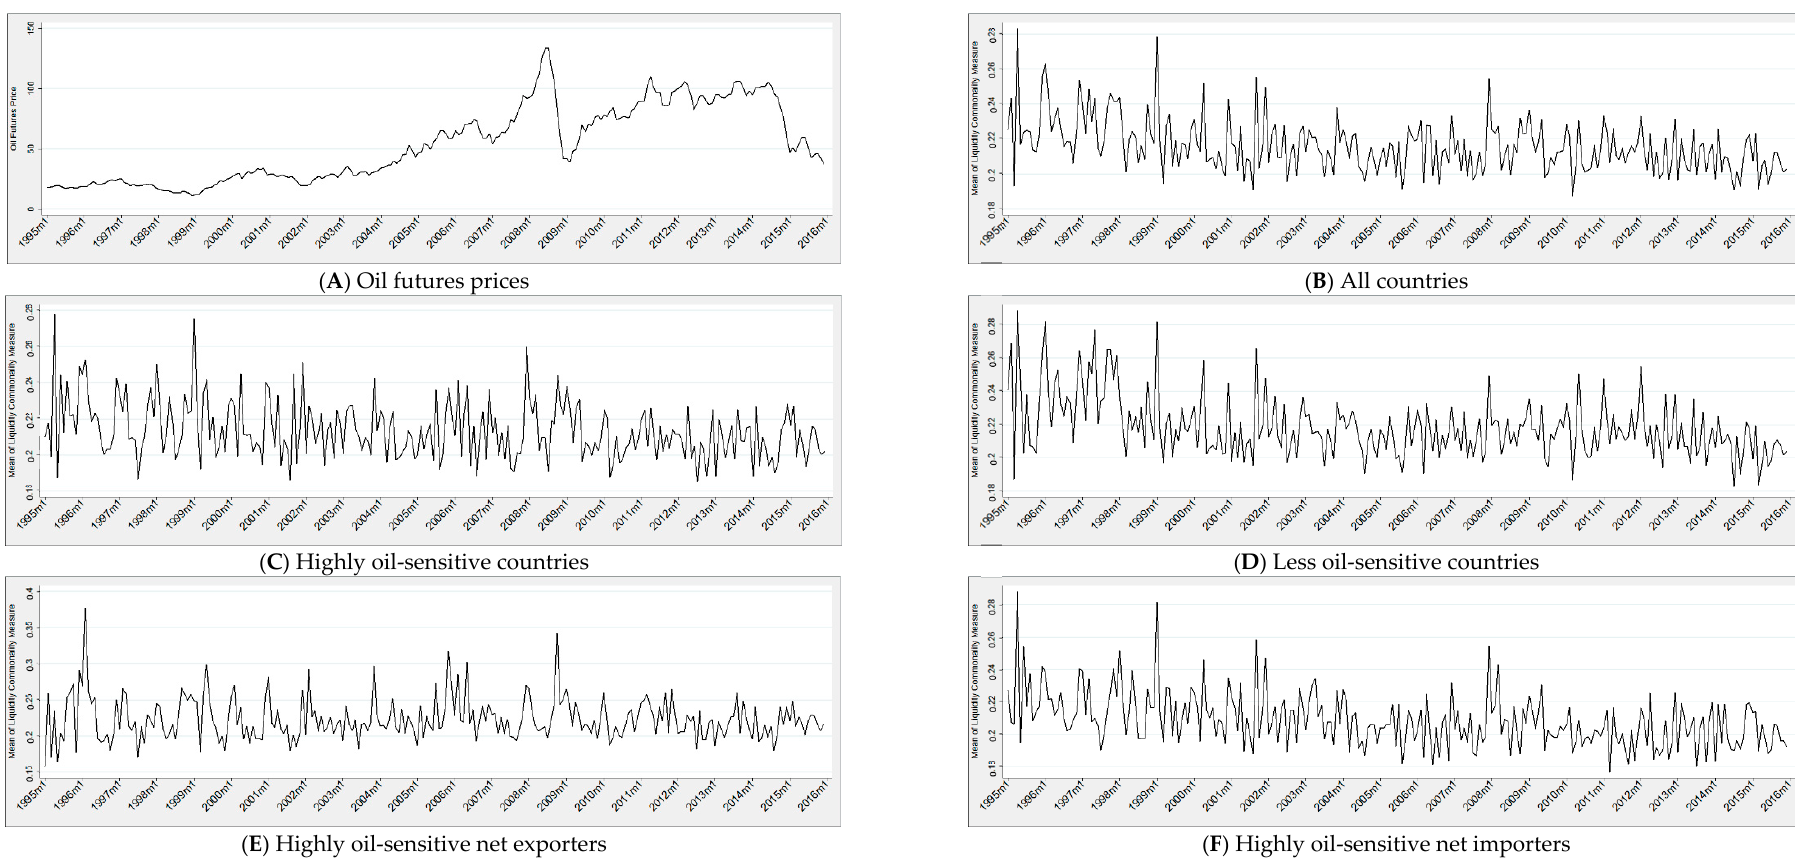
Figure 1. These graphs show the time series spanning from January 1995 to December 2015 of oil futures prices ( A ) and the average liquidity commonality measure ( 𝑅 (cid:3002)(cid:3040)(cid:3036)(cid:3035)(cid:3048)(cid:3031)(cid:2870) ) of all countries ( B ), highly oil-sensitive countries ( C ), less oil-sensitive countries ( D ), highly oil-sensitive net exporters ( E ), and highly oil-sensitive net importers ( F ). The liquidity commonality measure is defined in detail in Section 2.2.